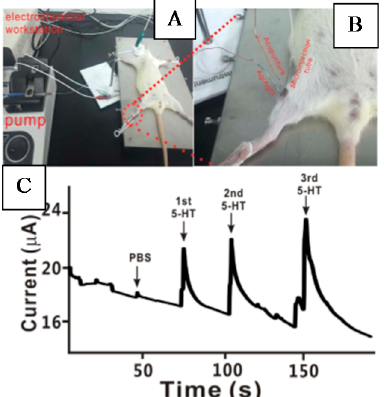
Figure 12. In vivo monitoring of 5-HT. ( A ) a photograph of the real-time and in vivo experiment after the rat was intraperitoneally anesthetized; ( B ) A zoomed picture; ( C ) the real-time recording of the inserted PEDOT/CNT/acupuncture needle in ST 36 upon the repeated injection of 10 µL, 10 − 5 M of 5-HT. Operating potential, 0.5 V vs. Ag/AgCl [137]. Copyright 2016, Nature.